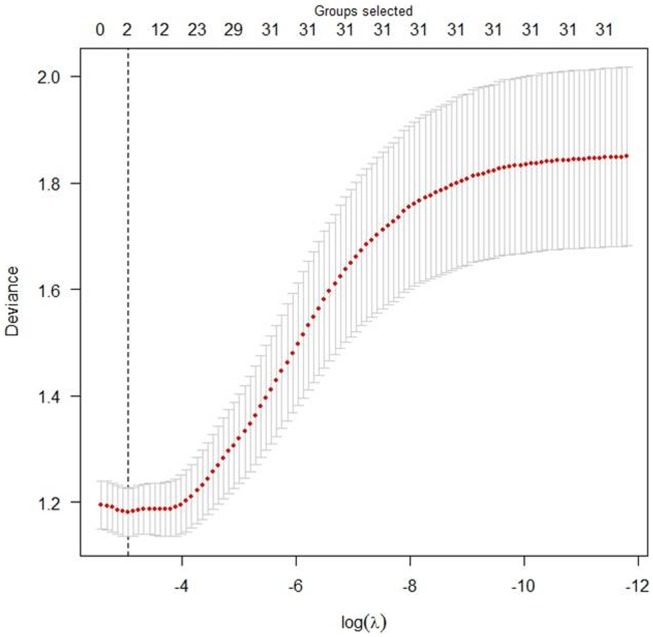
The deviance with error bar of the group Lasso logistic regression model using 10-fold cross-validation across different values of the tuning parameter  (log-scale).The total number of covariates is 31 and the corresponding number of dummy variables is 72. The optimal model is the one with deviance of 1.18 when  reaches 0.0471.